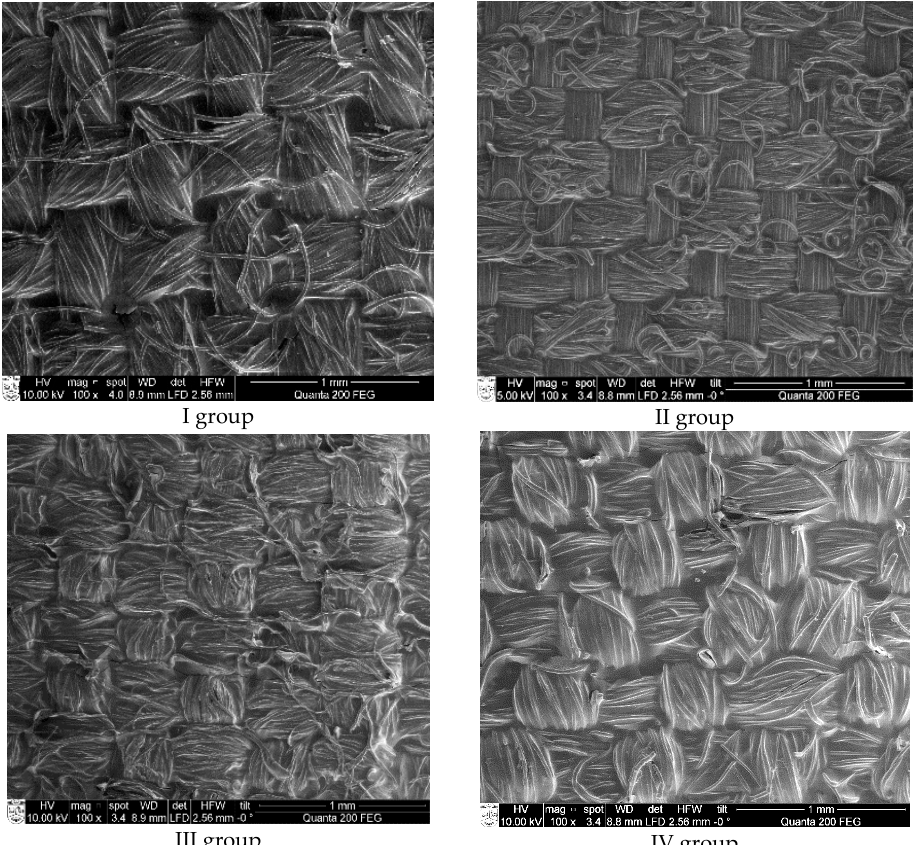
Figure 6. SEM images of samples coated with conductive